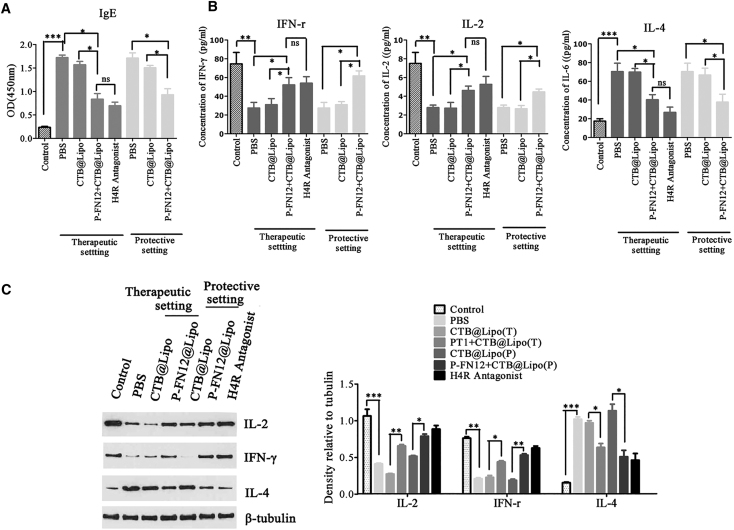
IFN-γ, IL-2, and IL-4 Expression Levels in Serum and Nasal Mucosa(A) OVA-specific IgE levels in serum measured via ELISA. (B) IFN-γ, IL-2, and IL-4 levels in serum as assessed via ELISA in both the therapeutic and protective settings. (C) IFN-γ, IL-2, and IL-4 expression levels in nasal mucosa as revealed by western blotting. The relative densities of the IL-2, IFN-γ, and IL-4 bands were normalized to that of β-actin. Each data point represents the mean ± SD of data from three independent experiments. Control, no AR group; ns, not significant; *p < 0.05, **p < 0.01, ***p < 0.001.